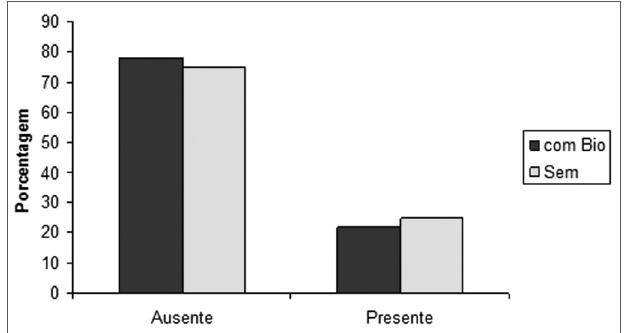
Figura 6. Porcentagem de animais que apresentaram ou não pro- cesso inflamatório agudo, nos grupos controle (sem) e experimental (com Bio). (Prova de Fisher: